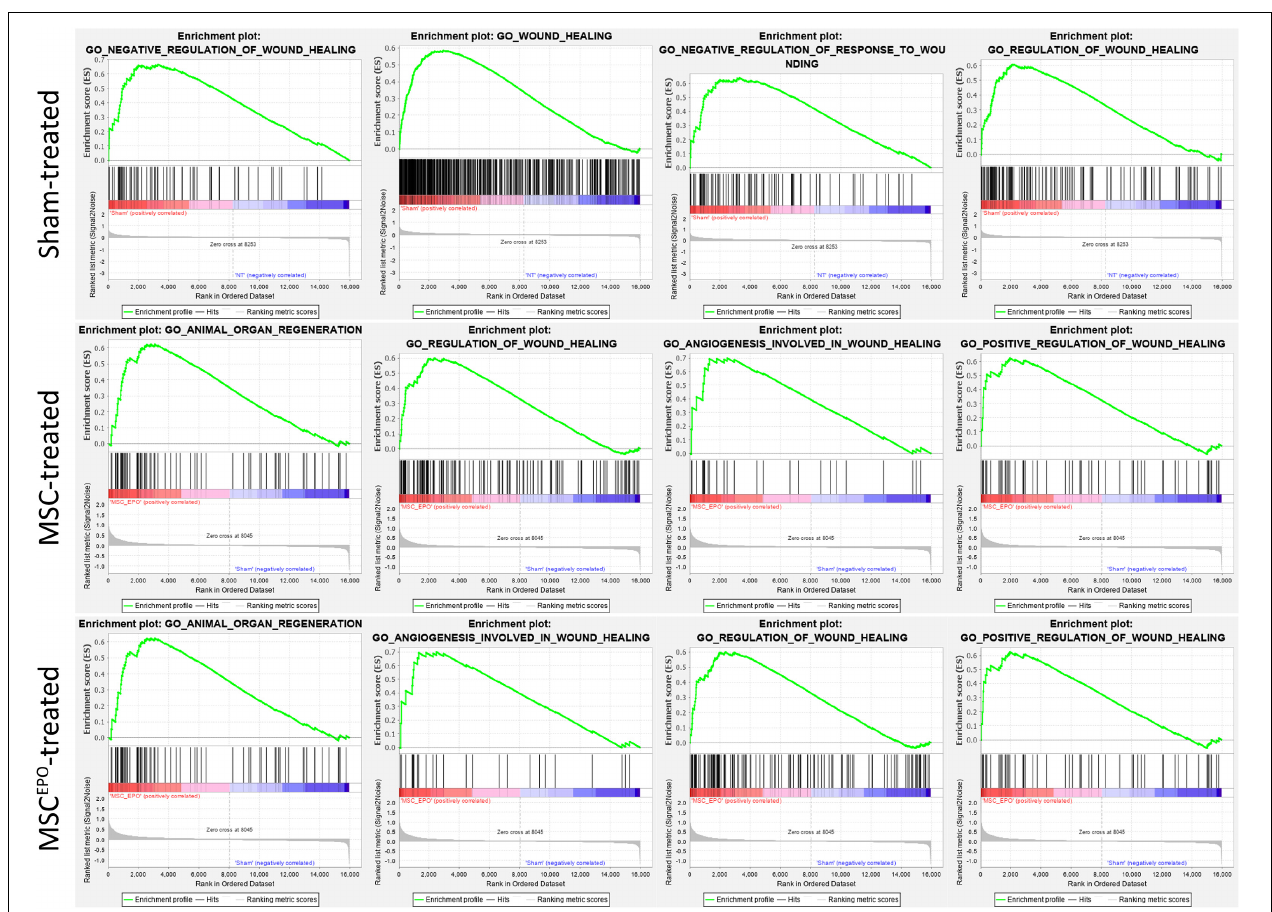
FIGURE 6 | Functional enrichment analysis with GSEA revealed the impact of MSCs and MSCs EPO on the healing capability of stem cell-treated retinas. Using GO biological processes as a reference database, enrichments in healing and regeneration were detected. The sham-treated group exhibited an enrichment involving mainly negative regulation of wound healing while regeneration and positively regulated healing gene sets were enriched in the MSC and MSC EPO -treated groups ( P adj <